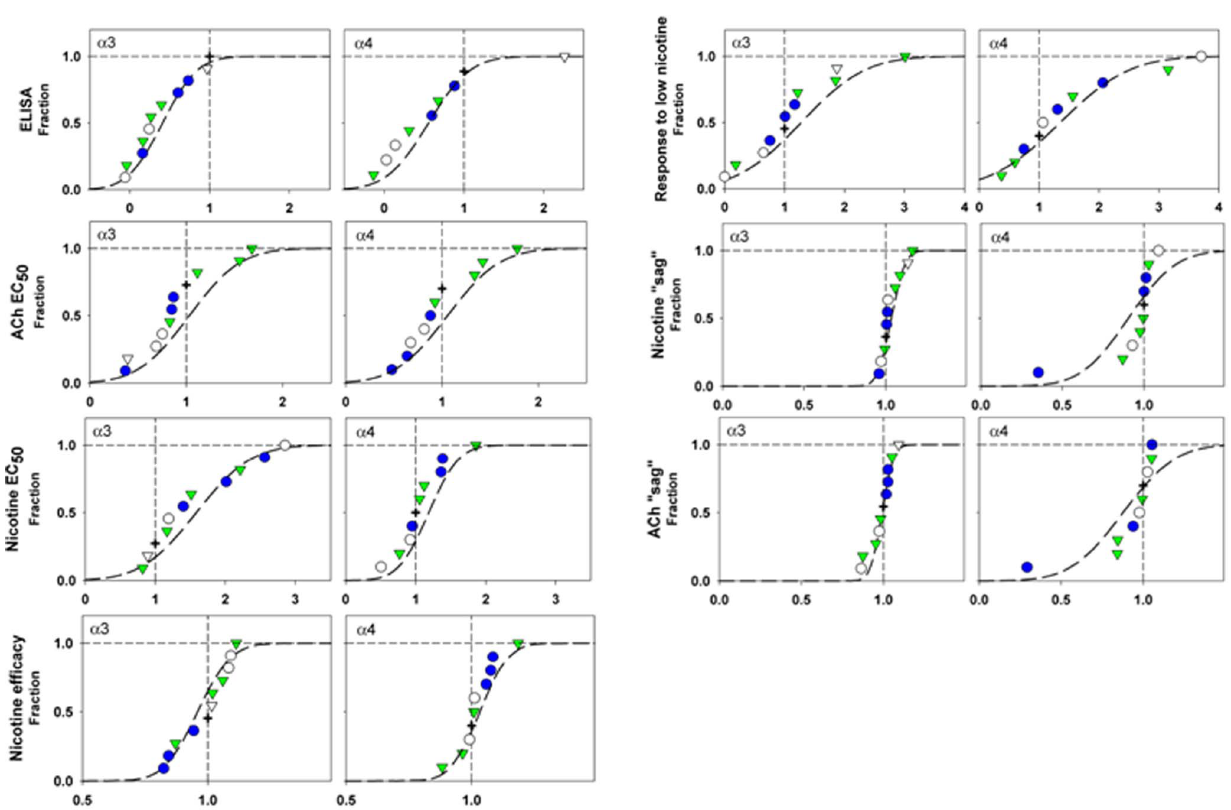
Figure 3. Consequences of variants for receptor properties. Each panel shows a cumulative distribution for the mean parameter values for receptors with different b 4 variants. The left graph in each pair shows data for receptors containing the a 3 subunit, and the right graph data for receptors containing the a 4 subunit. The parameter values have been normalized to the value for wild-type b 4 subunits to emphasize the relative functional changes (the actual data are shown in Tables 2 and 3). Data for receptors containing wild-type b 4 are shown by plus signs, for b 4 variants that have PhyloP scores less than 2 (‘‘nonconserved’’) by blue filled circles and for those with scores= . 2 (‘‘conserved’’) by green filled inverted triangles. Hollow symbols show values for variants occurring in only single individuals; these values were not used in the association analyses (see Results). The vertical dashed line shows a relative value of 1 (equal to wild-type). The dashed curves show the cumulative normal distribution predicted by the mean and standard deviation of the data excluding